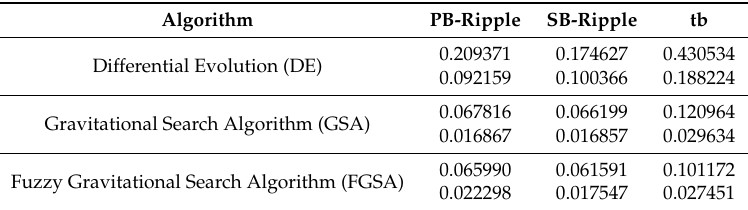
Table 4. Pass band ripple, stop band ripple and transition band of LP filters.